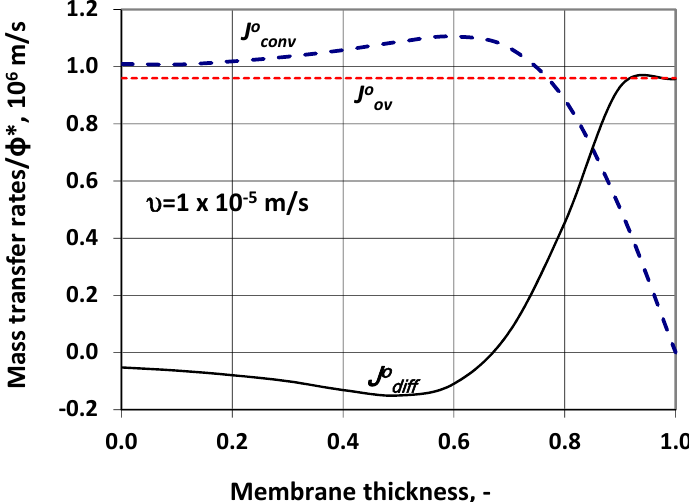
Figure 5. The convective, diffusive, and overall (sum of these two flows) mass transfer rates as a function of the local coordinate predicted by means of the data in Figure 4, with decreasing convective flow (data are the same with those given in the caption of Figure 4 ( υ i = υ (1 − 0.8 i / N )).